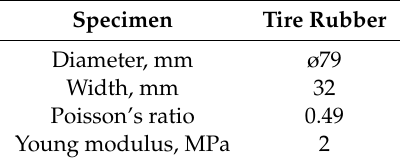
Table 2. Specification of rubber-wheel.